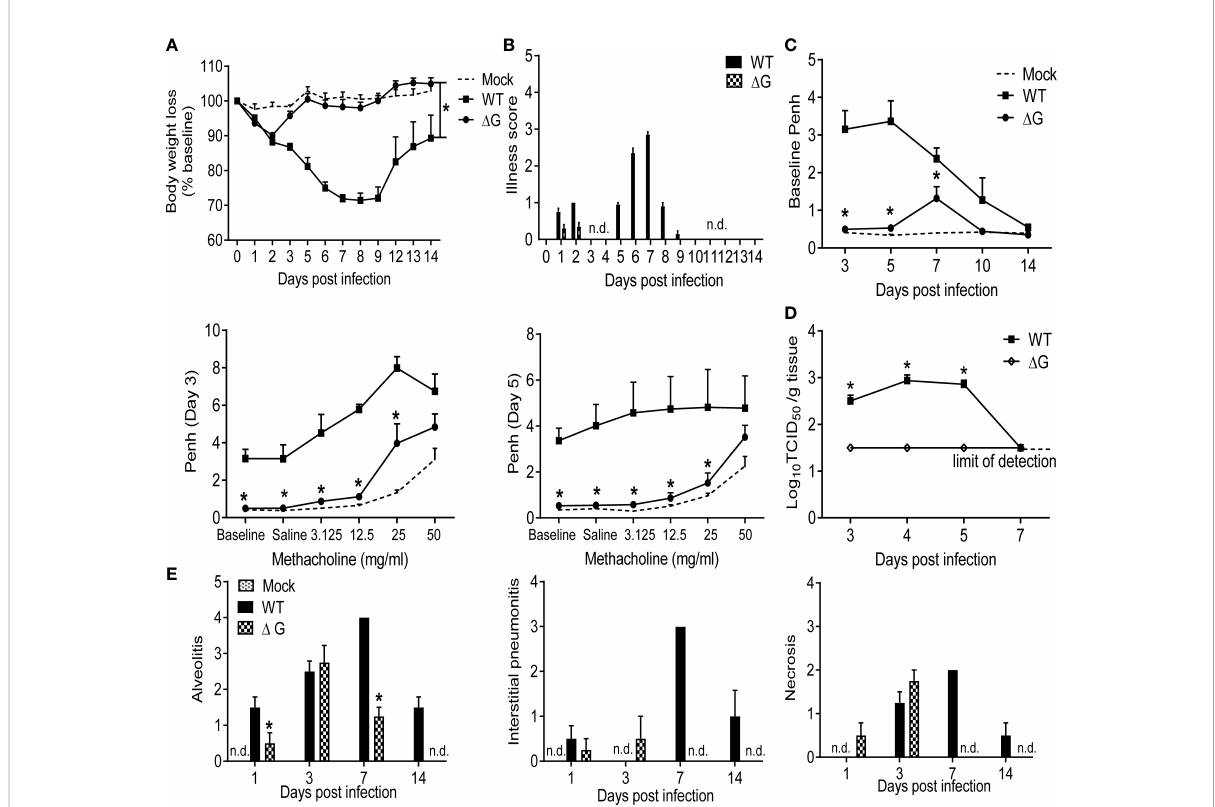
FIGURE 1 Clinical disease and virus replication. 6-8 wk old female BALB/c mice were either infected with rhMPV (-WT or - D G) or mock infected. (A) Change in body weight was measured over a period of 14 days. Body weight is expressed as percentage of baseline weight. (B) Illness score for infected mice infected was assessed daily by two observers using a grading scale from 0 to 5. (C) Baseline airway obstruction (left panel) and obstruction post-methacholine challenge (two right panels) was measured over a period of 14 days by unrestrained plethysmography. Day 3 and 5 p.i. are shown. (D) Infected mice were sacri fi ced at days 3, 4, 5 and 7 p.i. to determine viral titers by TCID 50 assay. The lower limit of detection of this assay is 1.5 log10/gram of tissue. (E) Lungs were formalin- fi xed for slide preparation, and hematoxylin and eosin stained. Alveolitis, interstitial pneumonitis and necrosis were scored on lung sections by a pathologist. Data are expressed as mean ± SEM of four to six animals/group and is representative of one of three independent experiments. *P<0.05 when comparing rhMPV - D G to -WT infected mice. rhMPV - D G = D G; rhMPV -WT = WT. n.d., not